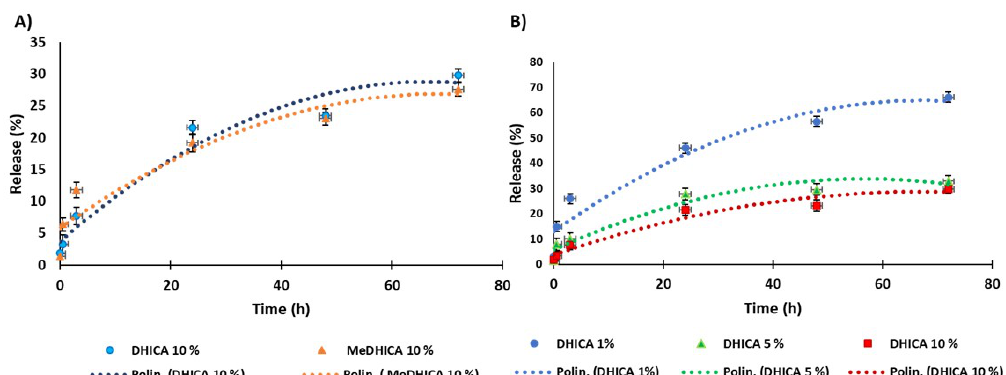
Figure 2. Release kinetics of 5,6-dihydroxyindole-2-carboxylic acid (DHICA) or the methyl ester of DHICA (MeDHICA) at 10% w / w (panel A ), and DHICA 1, 5, 10% w / w (panel B ) from pristine porcine skin type A gelatin (HGel-A) in PBS at pH 7.4 with refreshing of the medium over 72 h. Reported are the mean ± SD values of three experiments and the polynomial regression that fits the data.